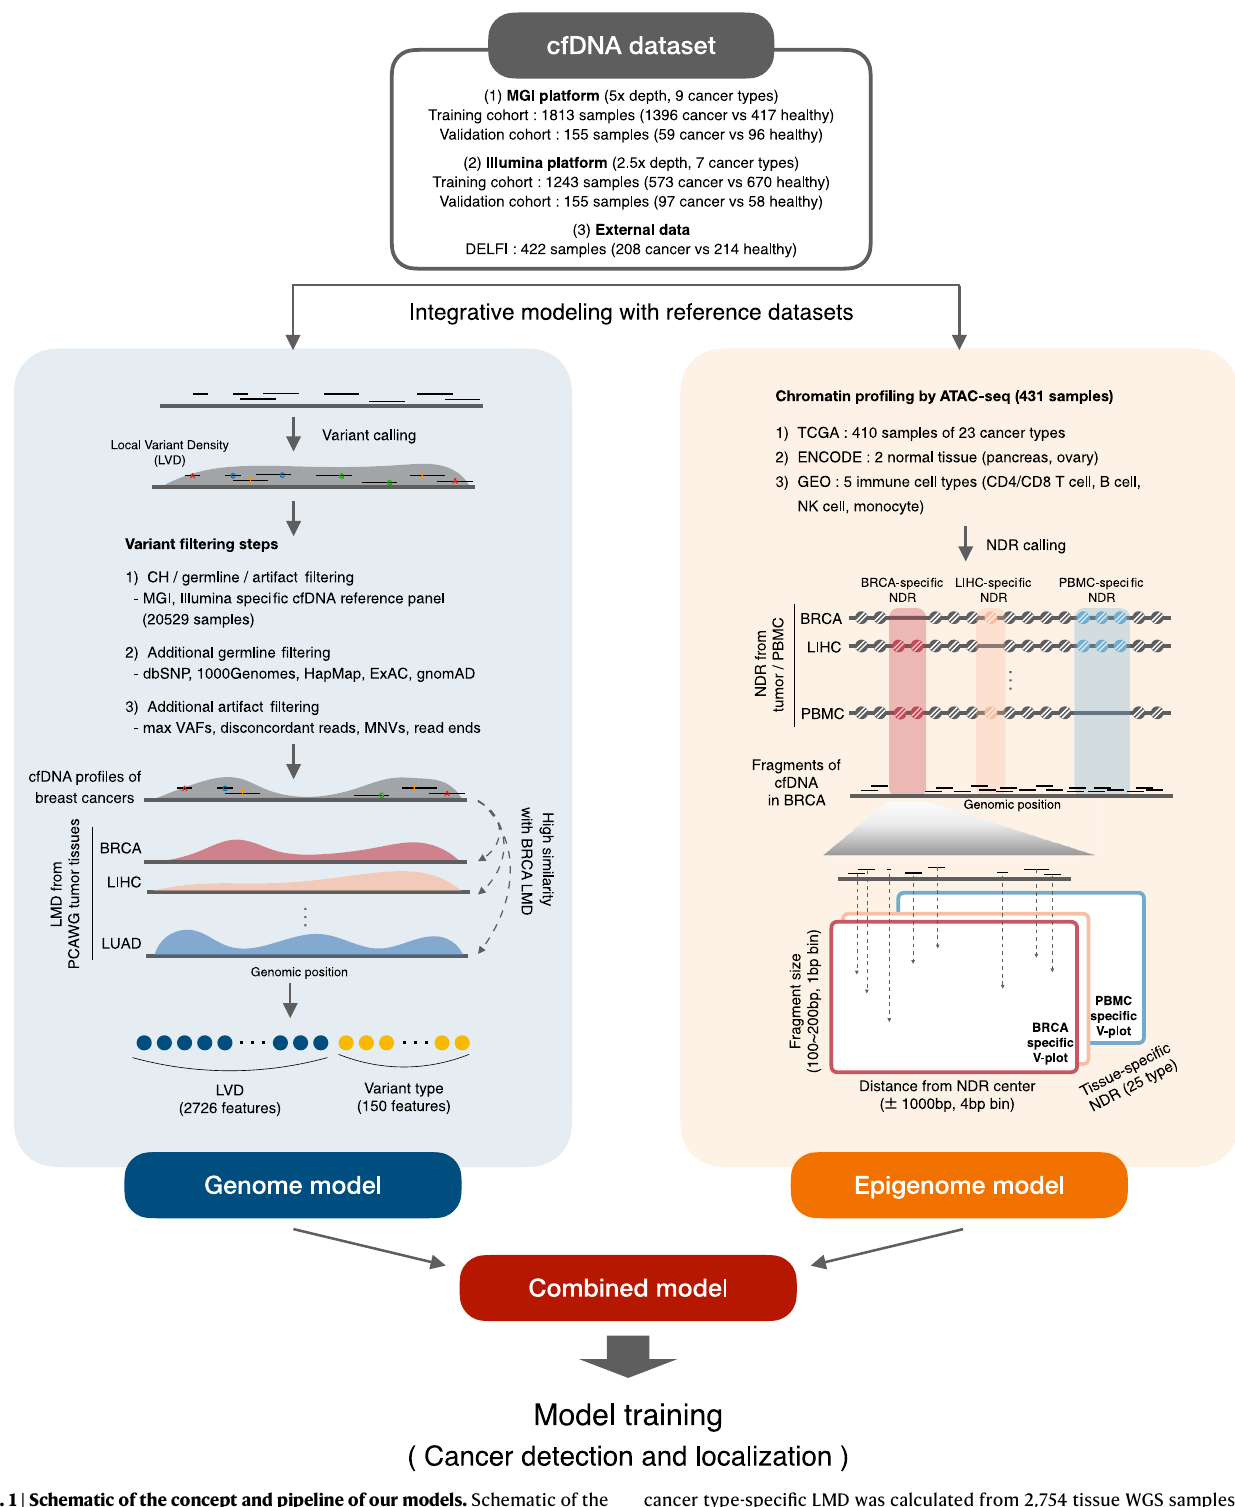
cancer type-speci fi c LMD was calculated from 2,754 tissue WGS samples. For the epigenome model, tissue-speci fi c NDRs were identi fi ed by processing ATAC-seq data for 431 samples obtained from public databases. cfDNA frag- mentation at the identi fi ed NDRs was fed into CNNs as three-dimensional V- plot images. Three different cfDNA WGS datasets, totaling 3788 samples, were used to testthegenomeand epigenome algorithms. Our data were preparedin two separate batches, representing the training and validation cohorts. BRCA Breast cancer, LIHC Liver hepatocellular carcinoma, LUAD Lung